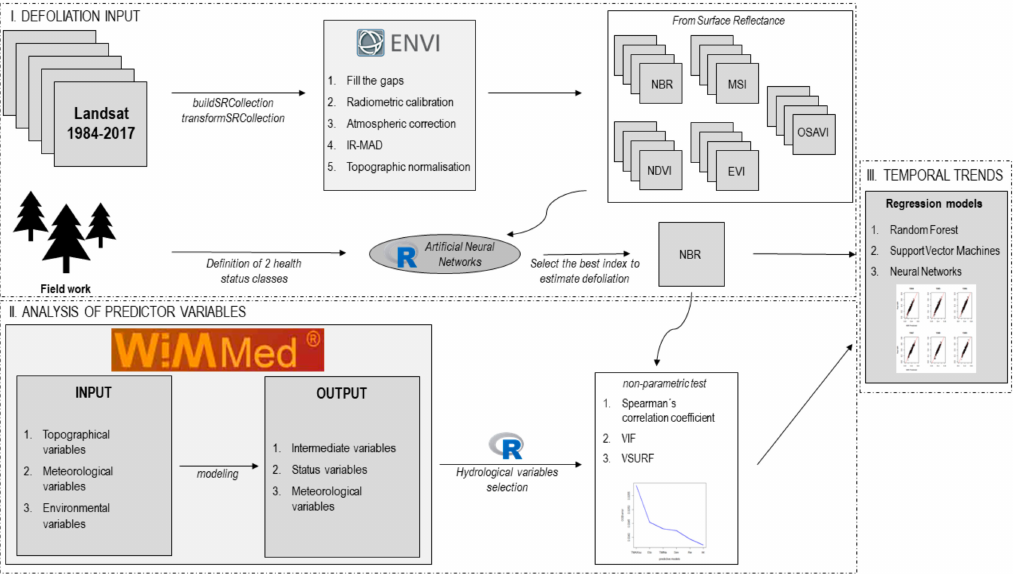
Figure 2. Flowchart describing the methodological steps to integrate Landsat time-series of Normalized Burn Ratio (NBR) and hydrological modeling to assess the forest defoliation of Pinus pinaster Aiton., in south-eastern